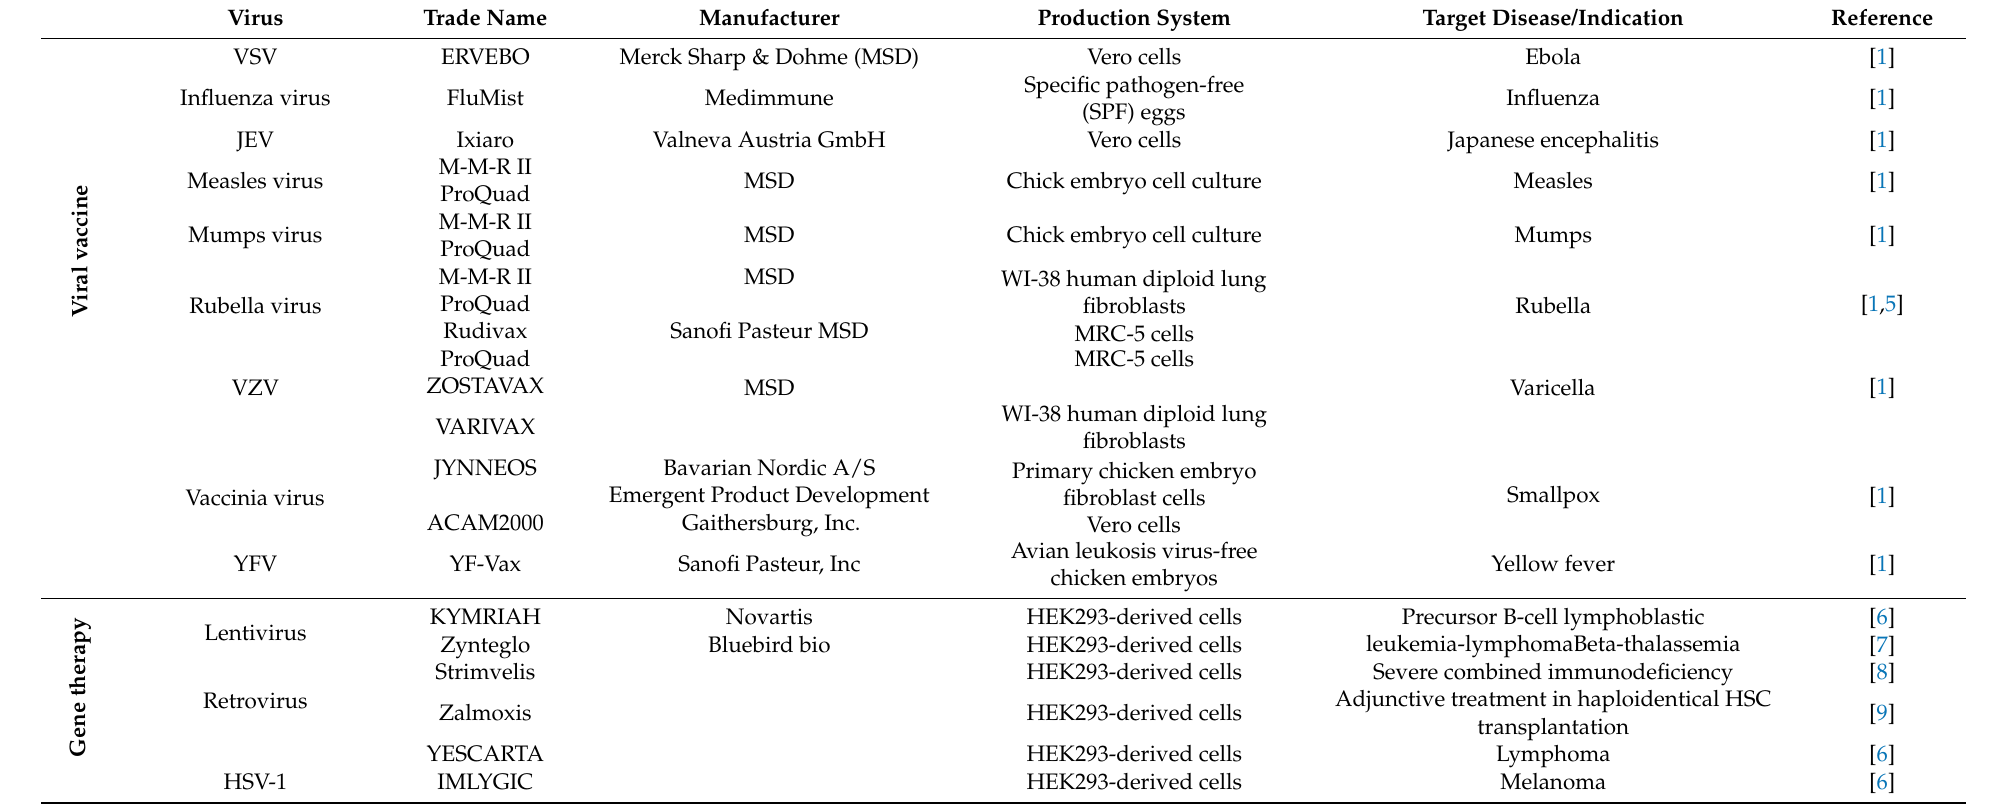
Table 1. Examples of approved vaccines and gene therapy products using whole enveloped viruses. VSV: vesicular stomatitis virus, JEV: Japanese encephalitis virus, VZV: varicella-zoster virus, YFV: yellow fever virus, HSV-1: oncolytic herpes simplex